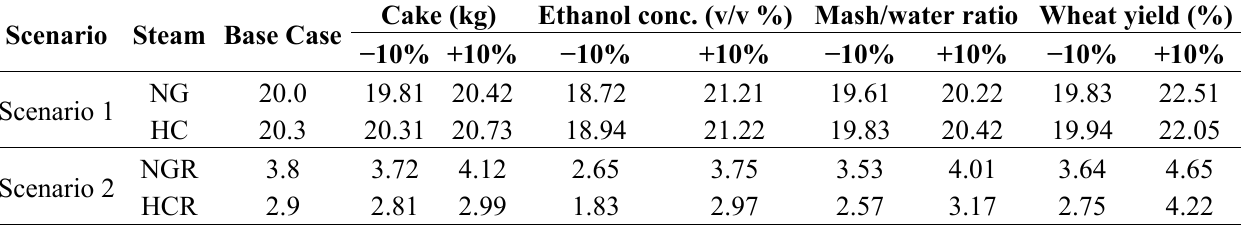
Table 2. Sensitivity analysis of factors related to NEG displayed in MJ/kg ethanol, total